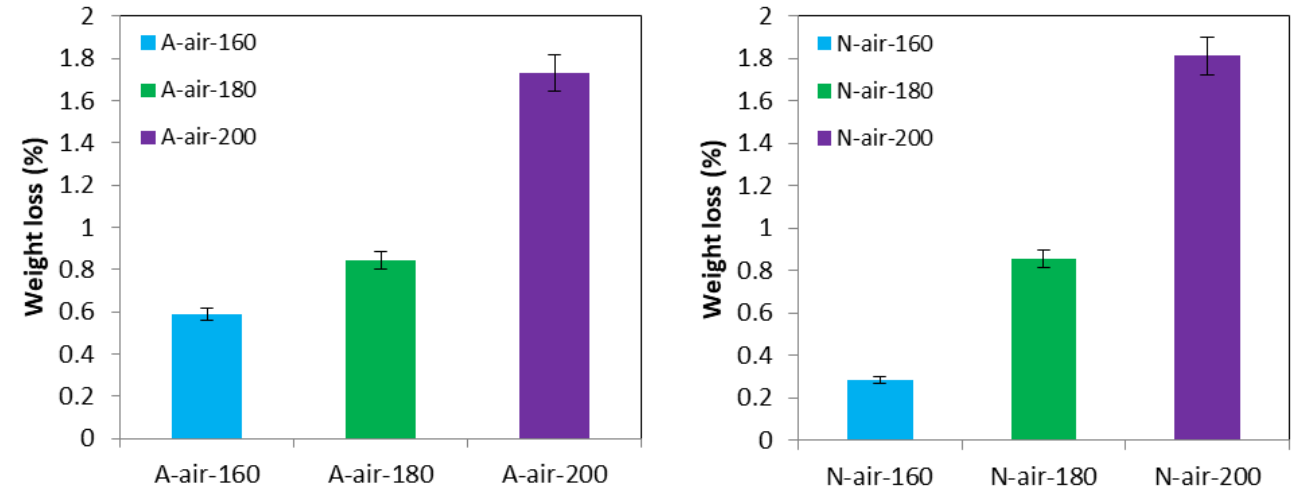
Figure 3. Weight loss of Afrormosia and Newtonia heat-treated under air.